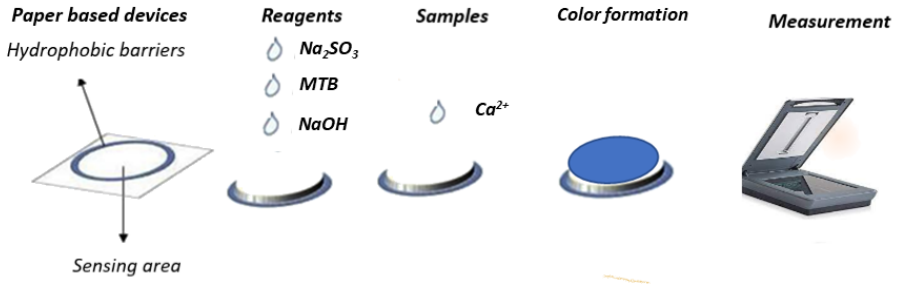
Figure 1. Experimental process for the paper-based analytical method for calcium determination.